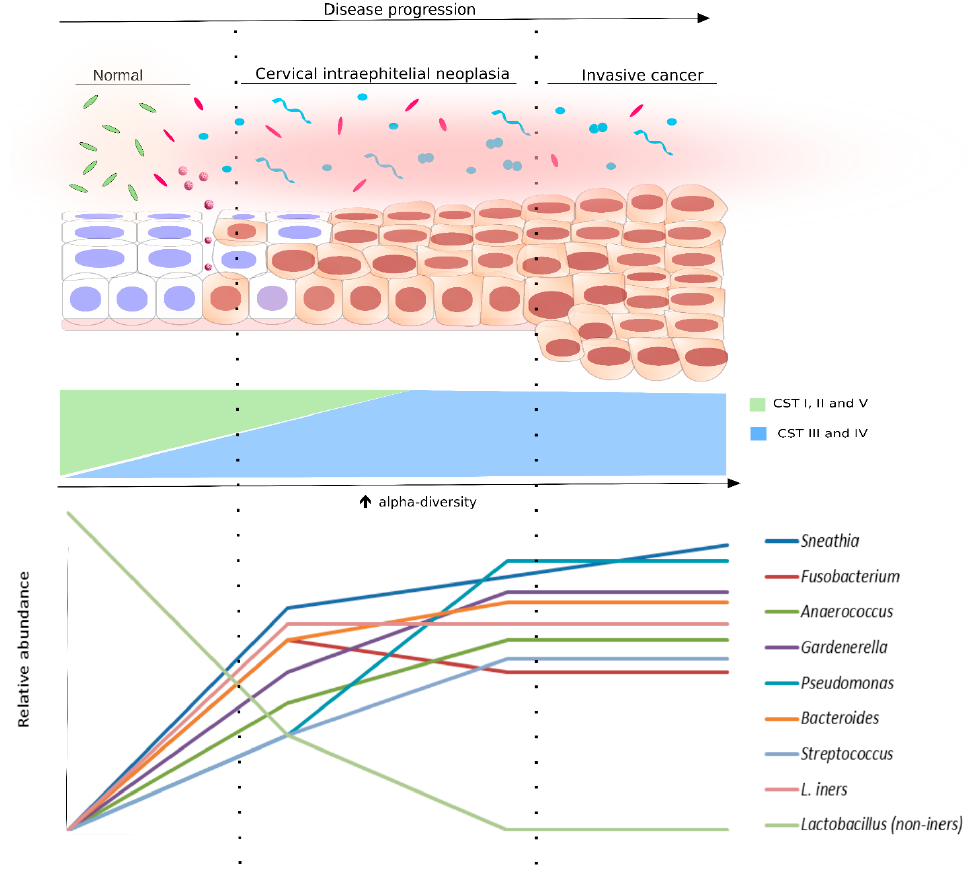
Figure 3. Bacterial diversity distribution in intraepithelial neoplasia progression. The scheme displays the progression of the cervical epithelium from normal to invasive cervical cancer, as well as the bacterial diversity (alpha-diversity) and the species abundance in the cervical microenvironment at each cytological stage. The normal cytology is commonly associated with CSTs I, II, or V, which are Lactobacillus species (non- iners )-dominant (light green rods). However, following the cervical disease progression, the relative abundance of Lactobacillus non- iners species start to decrease. Concomitant to that, alpha-diversity increases and the microbiota is changed to CST III (pink rods and circles) or IV (light blue and pink shapes). Some bacterial species were found, in different studies, associated with cervical disease progression. They are also displayed in this figure in a representative graph of relative abundance (lower panel).